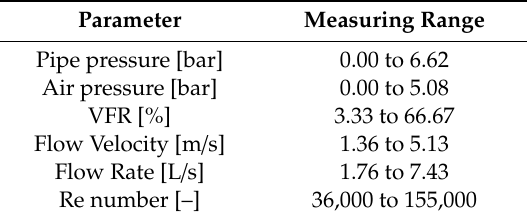
Table 1. System parameters summary.